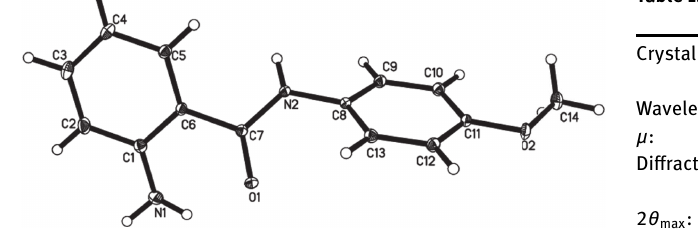
Table 1: Data collection and handling.